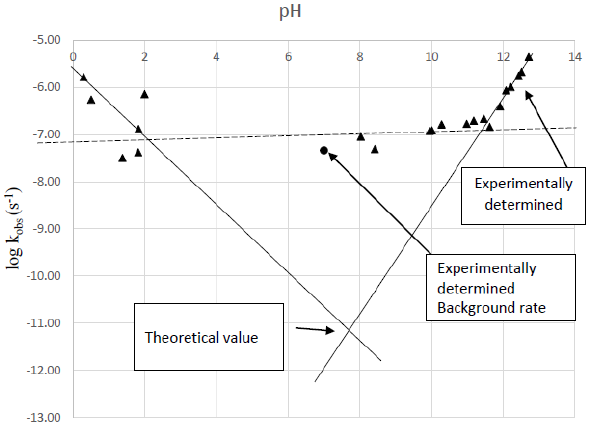
against pH for the hydrolysis of AMPNa obs